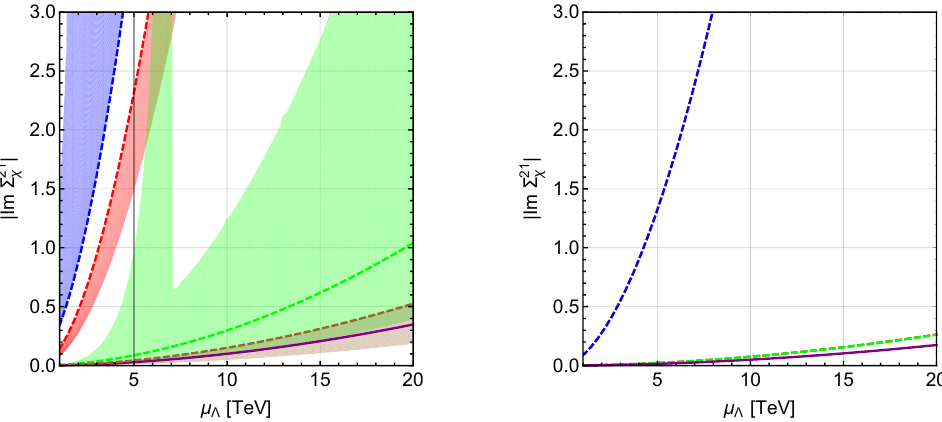
Figure 2. The j Im (cid:6) 21 j versus the LQ mass (cid:22) (cid:3) (cid:24) M LQ for (cid:12)xed (cid:20) " 0 = 0 : 5. [Left] for scalar models (cid:31) e S 1 [red], e R 2 [blue], S 3 [purple], S 1 [green] and R 2 [brown]. The bands indicate the variation